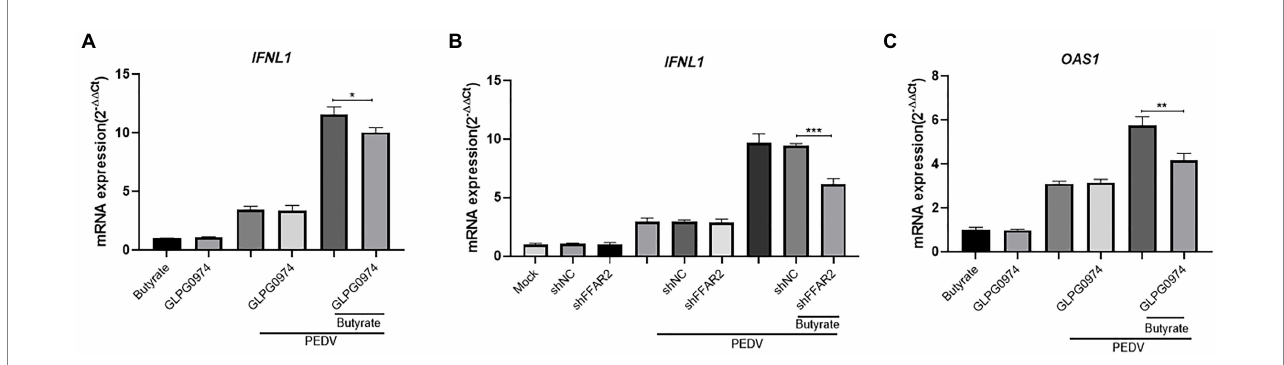
FIGURE 4 Butyrate inhibits IFN and ISG via GPR43 in IPEC-J2 cells. (A) IPEC-J2 cells were treated with 1 mM butyrate and 500 nM GLPG0974 for 24 h and then infected with PEDV. IFNL1 levels in butyrate-treated and PEDV-infected IPEC-J2 cells were assessed after 24 h. (B) IPEC-J2 cells were transfected with FFAR2 shRNA plasmids and pretreated with butyrate for 24 h. IFNL1 levels in butyrate-treated and PEDV-infected IPEC-J2 cells were assessed after 24 h. (C) OAS1 gene expression in IPEC-J2 cells treated with 1 mM butyrate and 500 nM GLPG0974 and then infected with PEDV for 24